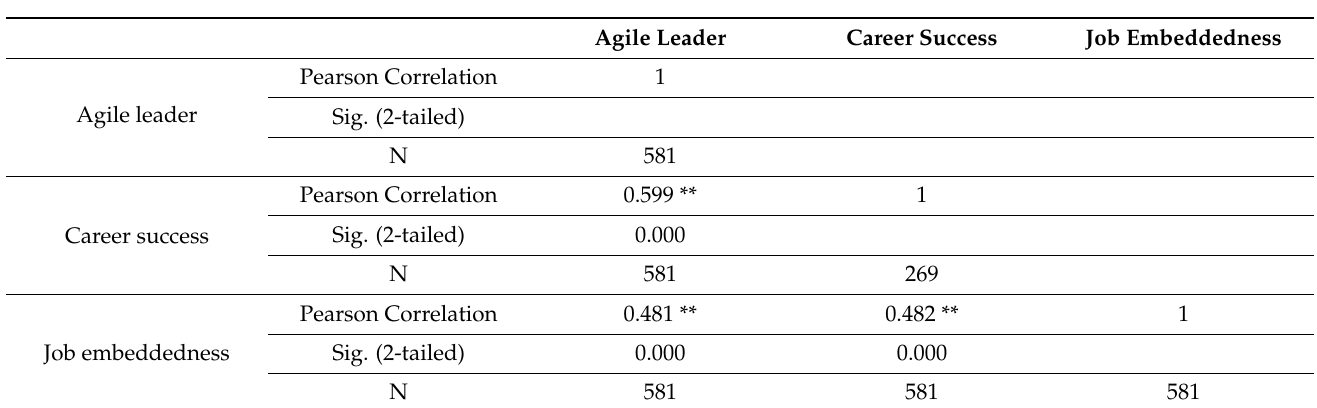
Table 2. Correlations.